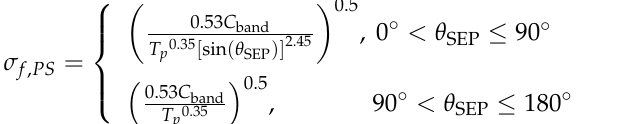
Figure 10. The frequency estimation error caused by phase scintillation (two-way and tree-way mode, X band). ( a ) full range of SEP angle; ( b ) enlarged view of SEP angle. The second error factor is thermal noise on both the uplink and downlink for the two- way and three-way mode in the Phase-locked-loop situation. As mentioned before, the thermal noise is always modeled as Gaussian white noise, and the error performance of the proposed method is no more than 1.0102 times that of CRLB when SNR is higher than 0 dB. Therefore, the white noise performance of the Tianwen-1 observation can be evalu- ated by the CRLB and has also been displayed in Table 2. The third error factor is the frequency stability of the oscillator at the station, which can be depicted as the Allan deviation of the carrier’s frequency source [26]. The Turna- round Light Time (TLT) for the Tianwen-1 observation is about 20 min. Moreover, the traditional Allan deviation of the hydrogen maser at 1000 s is about 2×10 − 15 . The Doppler measurement error caused by frequency source stable, σ f,FS , can be calculated as the fol- lowing formula, ( ) , 2 sky 2 log ( ) f FS A M f σ σ τ= + (36) where f sky is the sky frequency of downlink carrier, M equals to TLT/ τ , and σ A ( τ ) is the Allan deviation at time interval of τ . Therefore, the frequency estimation error caused by frequency source stability in the Tianwen-1 observation is about 0.03 mHz. 0